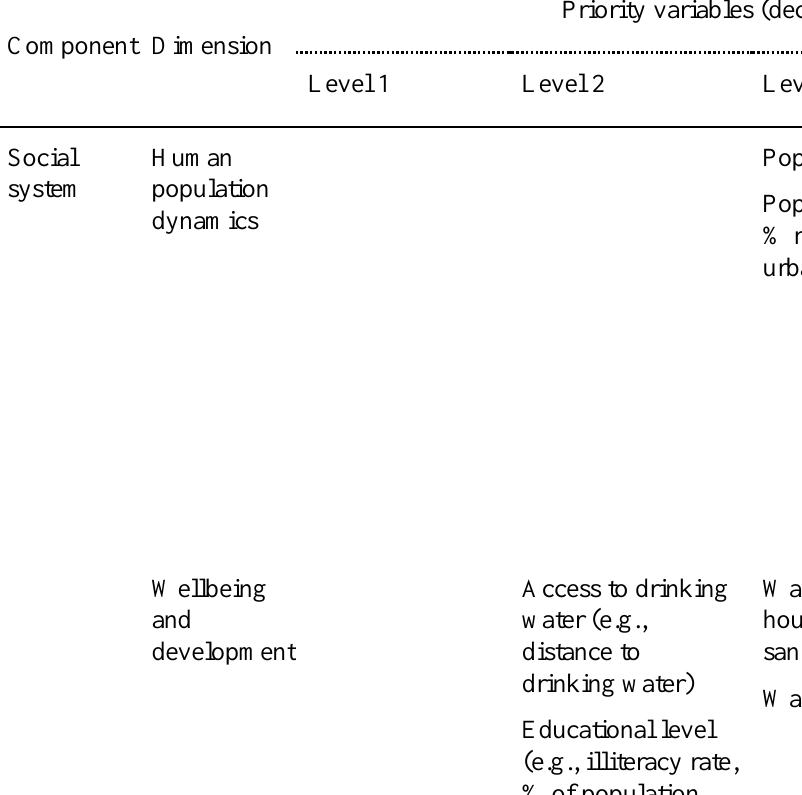
Table A5.2. List of prioritized variables for characterizing and monitoring SES (extended version with examples and explanations). The list is structured into 13 dimensions across the three components of a SES (Fig. 2 in the paper). Priority level 1 (top priority) includes variables with relevance and consensus above the 90 th percentile; level 2 includes variables between the 75 th and 90 th percentiles; level 3 includes variables with relevance above the 75 th percentile but consensus between the 50 th and 75 th percentiles and vice versa; and finally, level 4 includes variables with relevance and consensus between the 50 th and 75 th percentiles. The nonpriority category includes variables with relevance and consensus below the 50 th